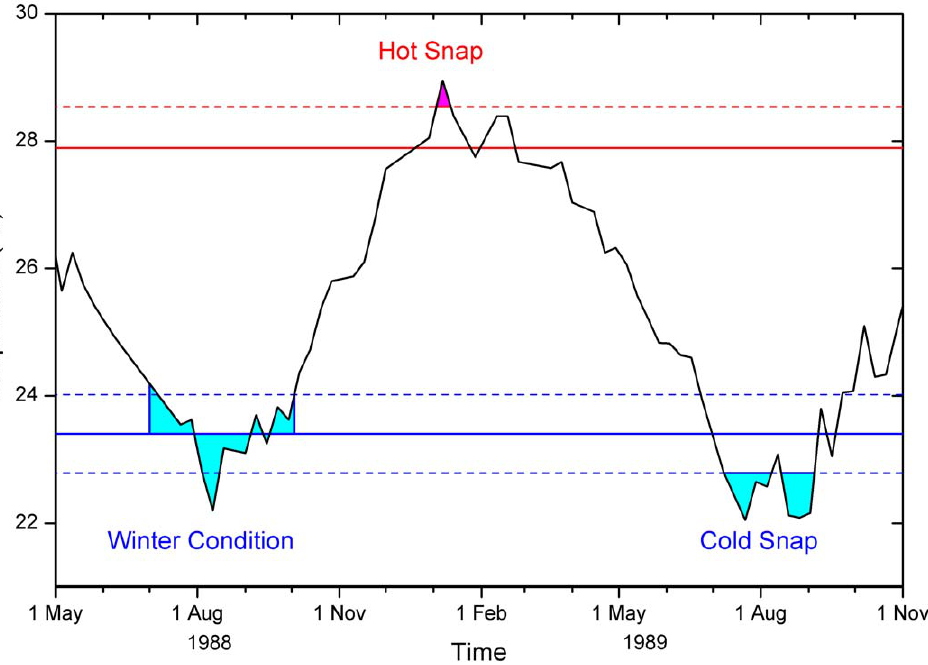
Figure 2. Temperature metrics for a sample temperature time-series. Shown for Slate Reef (149 u 55 9 E, 19 u 40 9 S). The Hot Snap metric accumulates when temperature exceeds the summer-mean (solid red line) plus one summer-standard-deviation (dashed red line). The Winter Condition metric accumulates anomalies with respect to the winter mean (solid-blue line) that are within the three winter months and/or below the winter-mean plus one winter-standard-deviation (dashed blue line). The Cold Snap metric accumulates when temperature drops below the winter- mean less one winter-standard-deviation (dashed blue line).